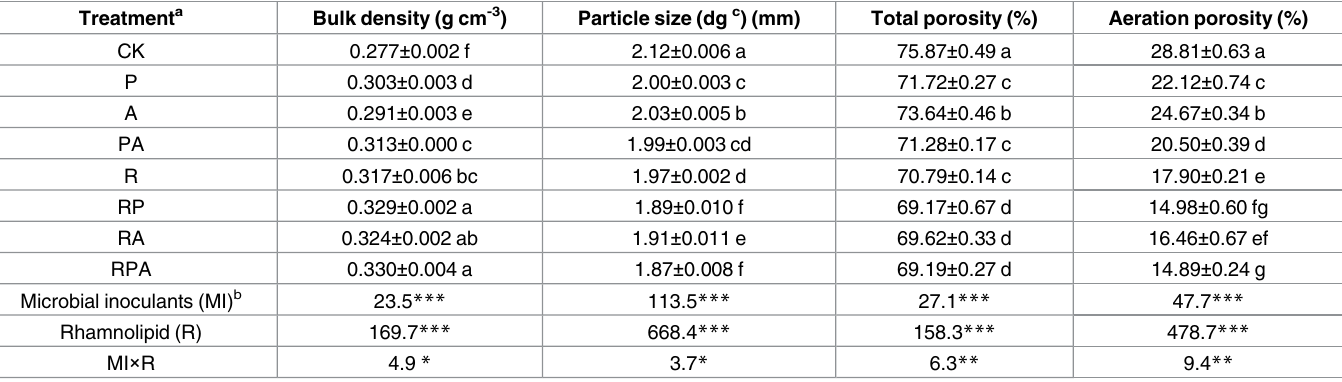
a Treatment abbreviations are explained in Table 1. Values are means ( ± SD, n = 3). Means in the same column followed by different letters are significantly different at P < 0.05 according to the LSD test. b The effects ( F values) of the microbial inoculants, rhamnolipid, and their interaction are indicated in the bottom three rows. ns, * , ** , *** indicate not significant and statistically significant at P < 0.05, < 0.01, and < 0.001, respectively. c dg: geometric mean